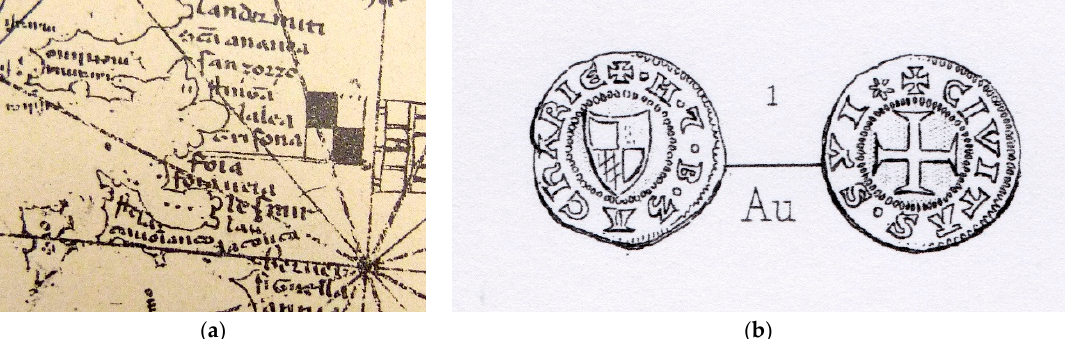
Figure 11. Coat of arms of the Genoese family the Zaccaria in Chios. ( a ) Banner of the family Zaccaria marking the port of Focea (Foca), Angelico Dalorto’s Portolano, Genoa, 1325. Florence, Corsini Collection. Source: (Magnaghi 1898). ( b ) Coin of Martin and Benedetto II Zaccaria in Chios (1319–1329). Source: (Schlumberger 1878).